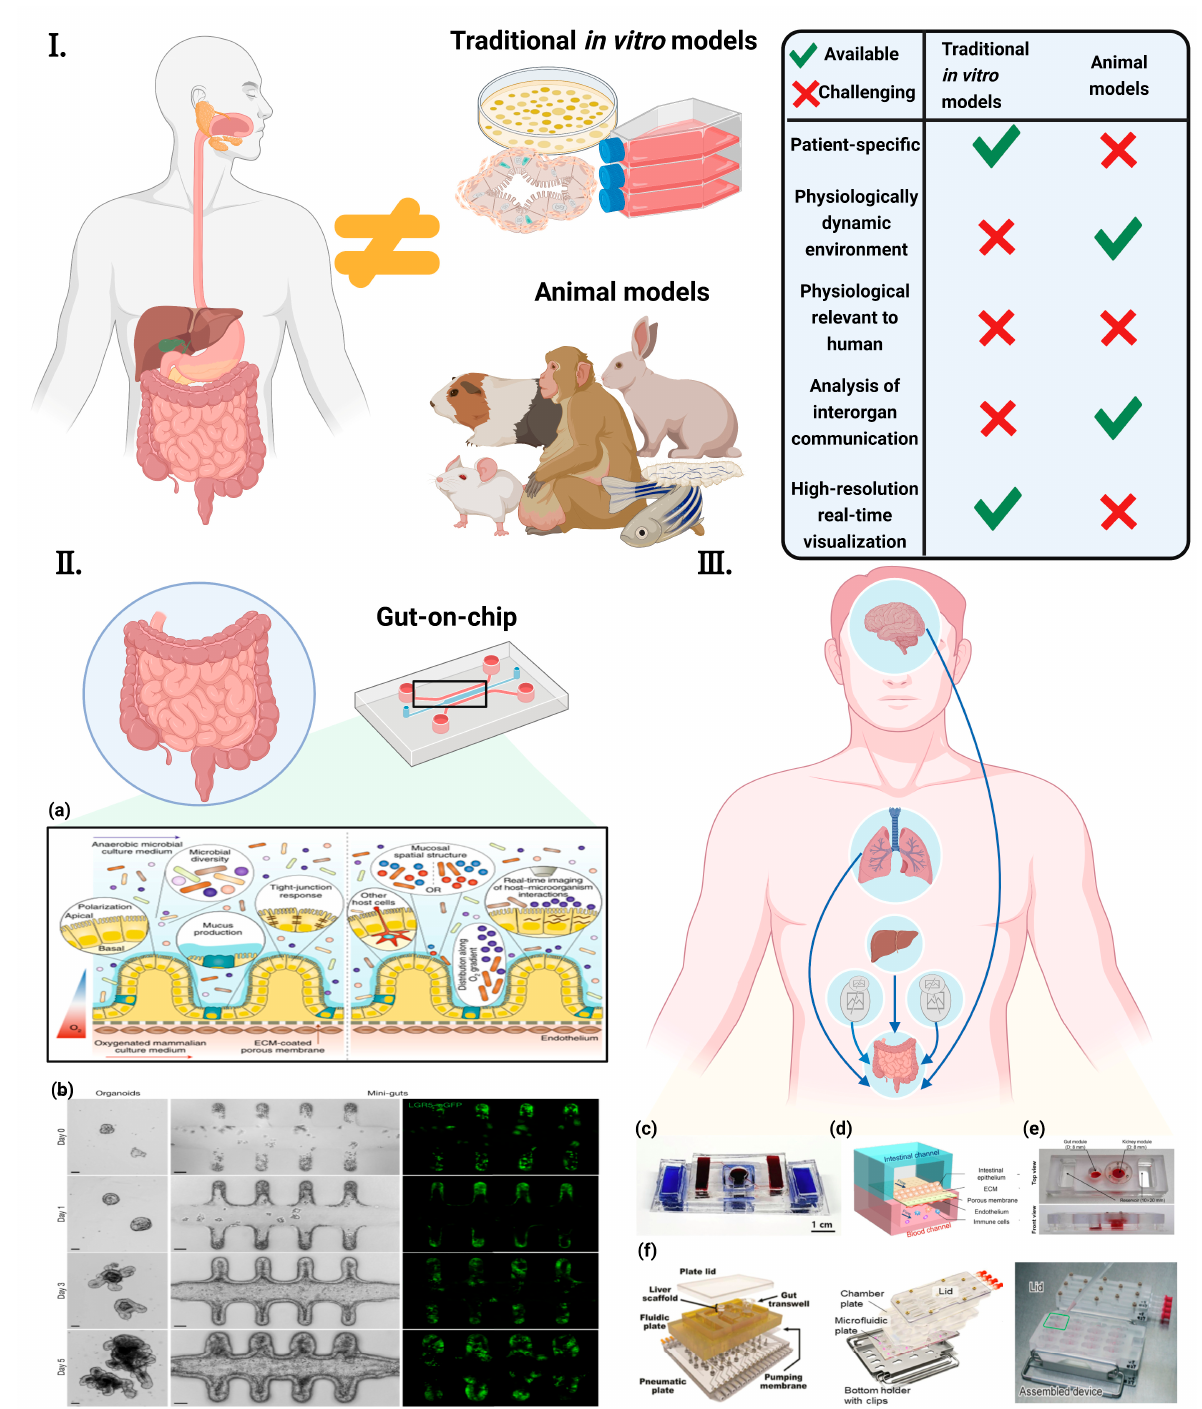
Figure 1. Concept of “gut-axis” organ-on-a-chip ( I ) Conventional in vitro models and animal models are physiologically different from the human body. They also hinder the understanding of human diseases and the development of new therapeutic strategies [27] ©Copyright 2021, MDPI. ( II ) The concept of the GoC simulates the dynamic 3D microenvironment of an organ on a small scale. ( a ) Human-gut-microbiome on a chip [28] ©Copyright 2019, Nature.; ( b ) Establishment of long-term homeostatic culture of tubular mini-guts [29] ©Copyright 2020, Nature. ( III ) “Gut-axis” organ-on- a-chip. ( c ) Gut–brain axis on chip [30] ©Copyright 2021, Elsevier. ( d ) Gut–lung axis on chip [31] ( e ) Gut–kidney axis on chip [32] ©Copyright 2021, Elsevier. ( f ) Gut–liver axis on chip [33] ©Copyright 2017, Wiley [34] ©Copyright 2021, Nature. [35] ©Copyright 2020, Royal Soc Chemistry.